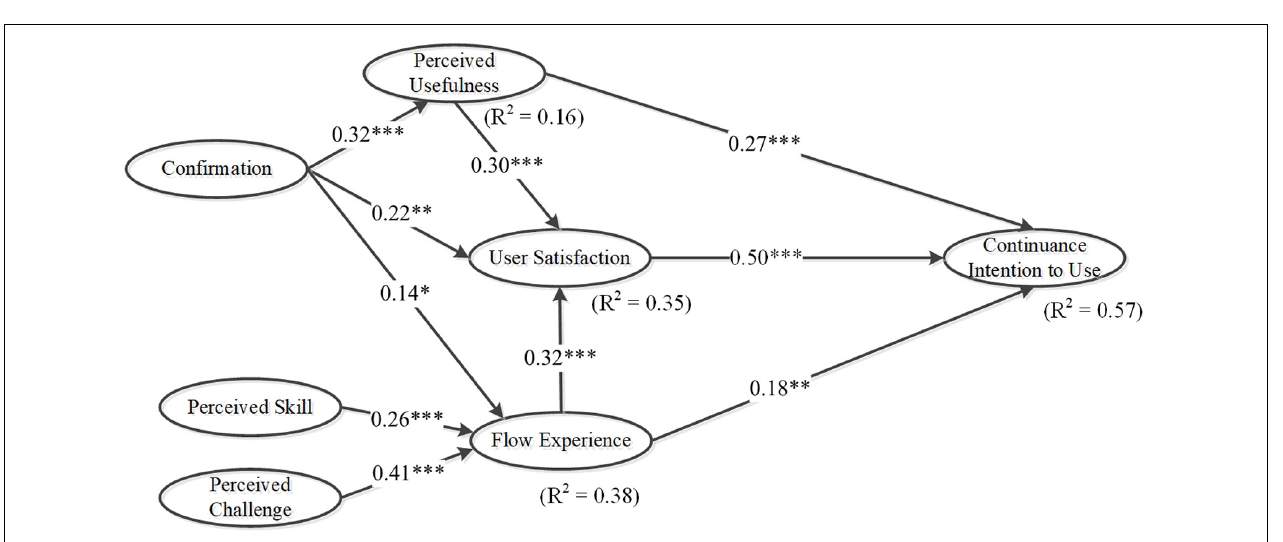
FIGURE 2 | Results of the full sample.